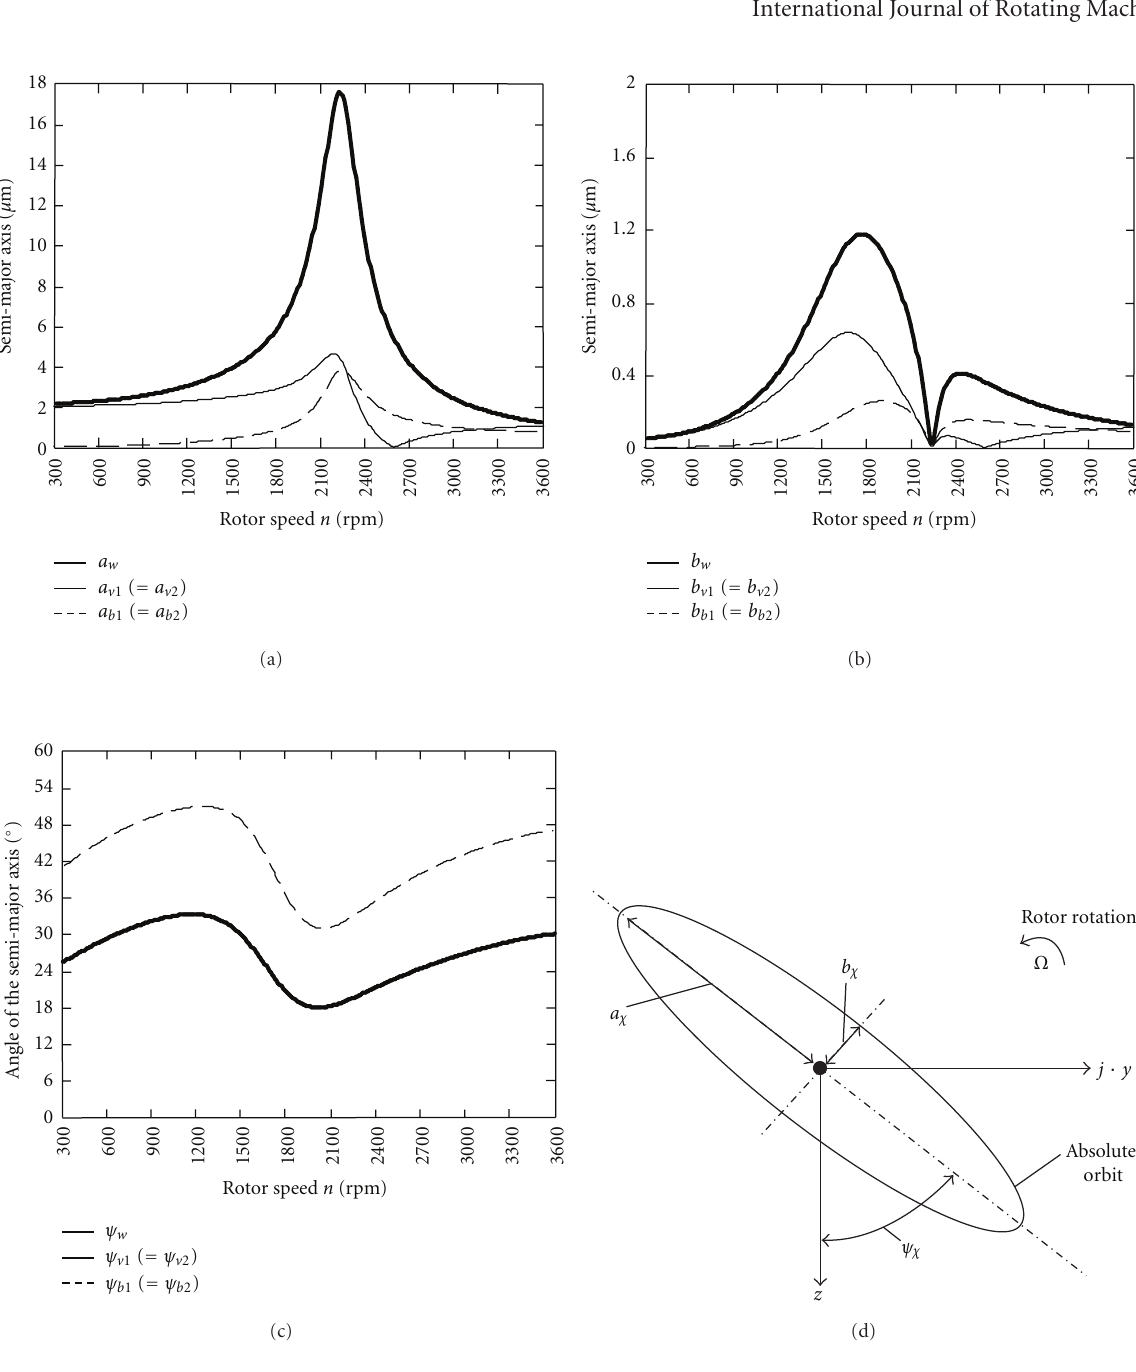
housing vibrations are analyzed for identical orientation of the elliptical shaft journals ( ϕ 1 = ϕ 2 ). In this case the bearing housing vibrations for both bearing housings are